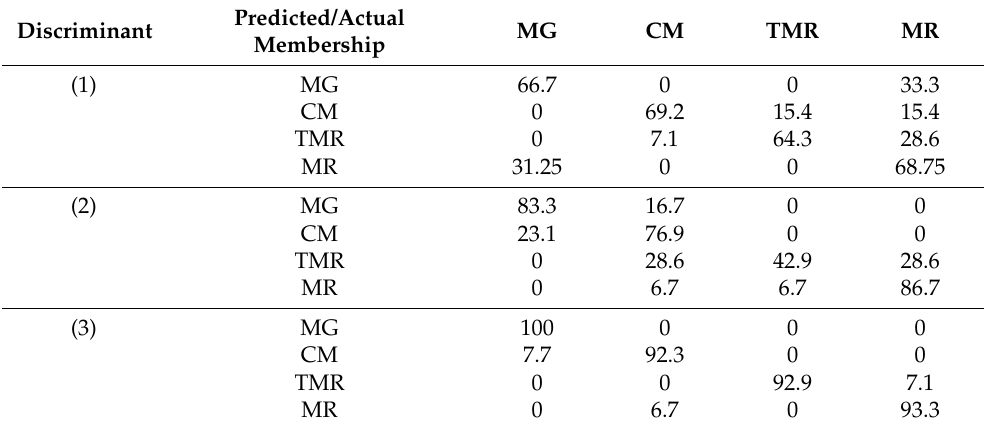
Table 4. Discriminant analysis: percentage of animals correctly classified according to their feed- ing